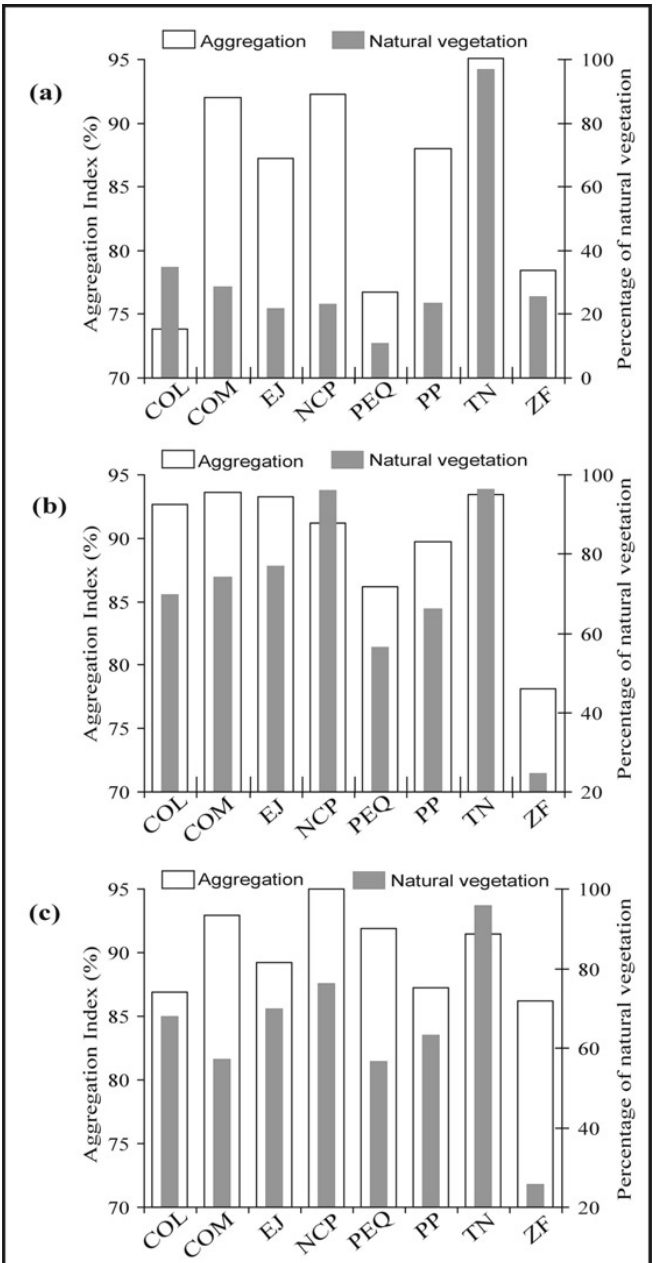
Fig. 2. Aggregation Index (AI, empty bars) and percentage of natural vegetation (PNV, gray bars) by land ownership type, in three subregions: (a) Costa del Golfo, (b) Llanuras, and (c) Sierras. Land ownership types include: COL= colonia, A settlement for agriculture/cattle-raising), COM= communal, EJ= Ejido, NCP= new population settlement (new Ejido), PEQ= small private property, PP= private property, TN= Nation lands, and ZF= federal